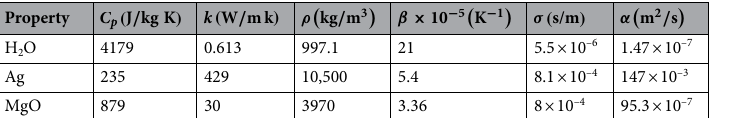
Table 1. Thermo-physical characteristics of the nanoparticles and the fluid 46 .